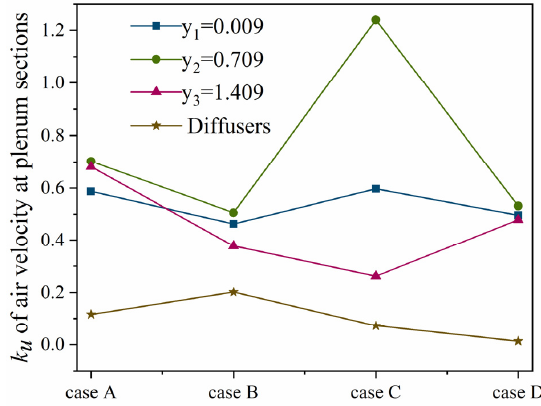
Figure 15. Air velocity non-uniformity coefficient inside plenum and at diffusers.